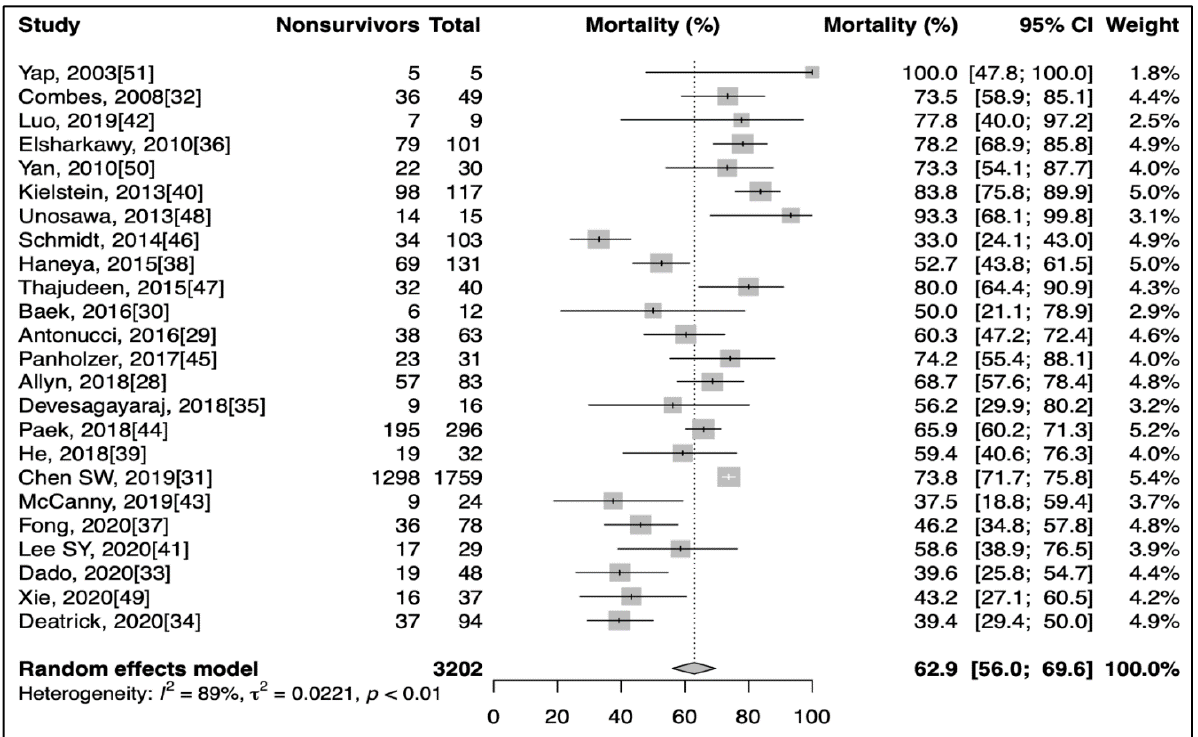
Figure 1. Forest plot showing pooled mortality.